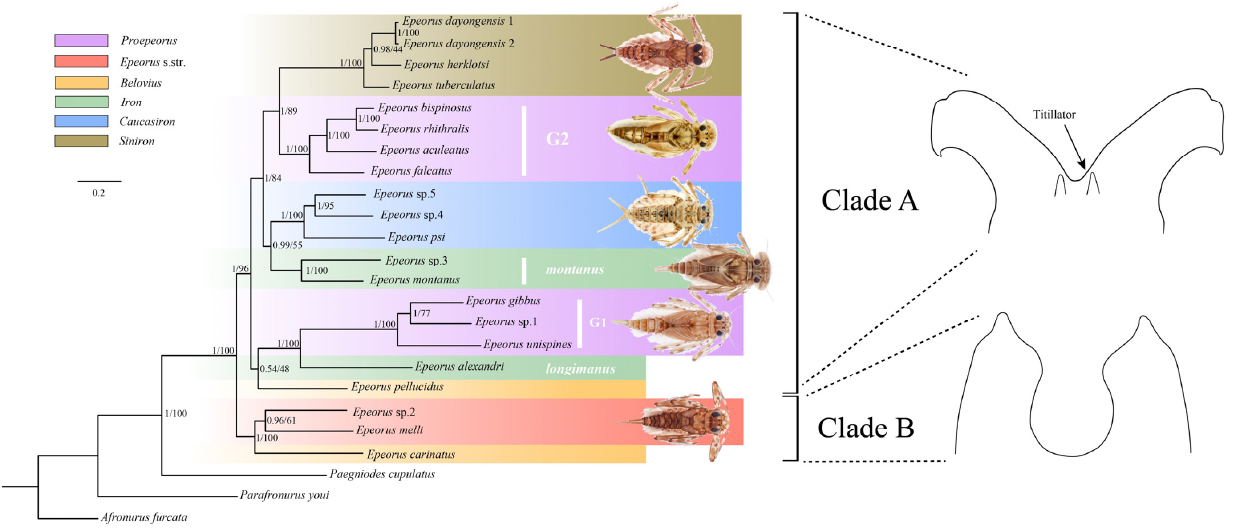
Figure 6. Phylogenetic relationships of Epeorus constructed by BI and ML methods based on datasets PCGs. Numbers separated by a slash on node are posterior probability and bootstrap values. The line drawings represent two types of genitalia of the clade A and B.